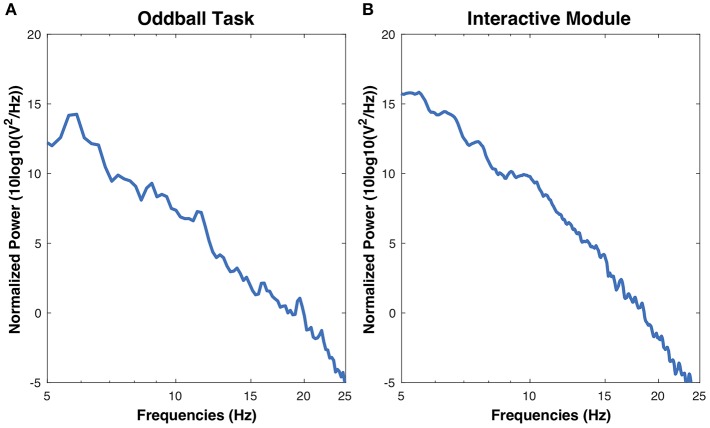
Power spectral densities estimations for the oddball task and the interactive module. PSDs for both were calculated using Welch's power spectral density estimation.